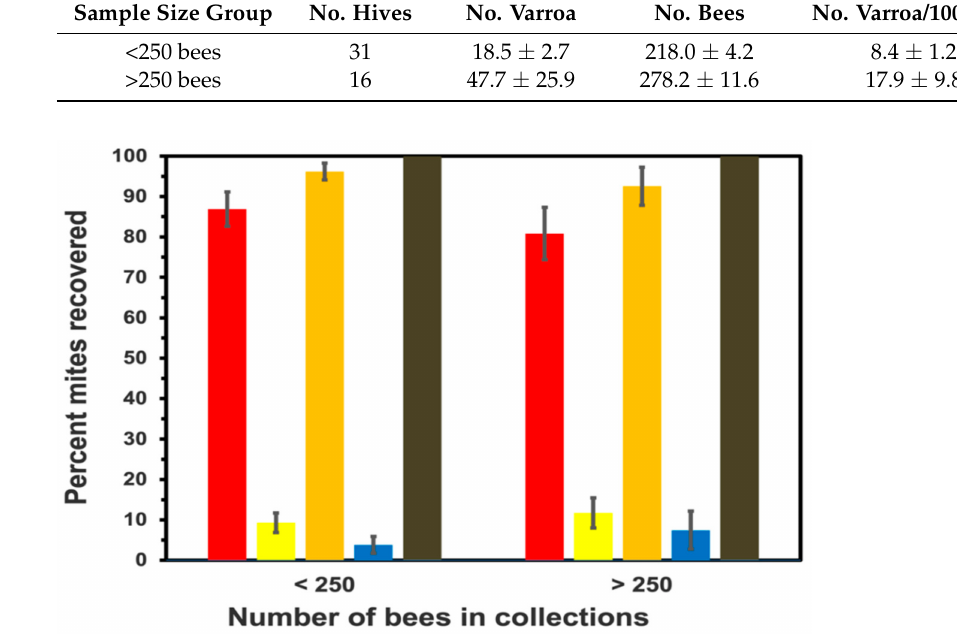
Figure 2. The percentage (mean ± standard err (se)) of Varroa dislodged from fewer or more than 250 collected honey bees after shaking the Varroa Shaking Device (VSD) for one minute with water (<250 N = 31; >251 N = 16 trials). The efficiency was estimated for first (red bar) and second (yellow bar) shaking periods, followed by the residual percentage collected from careful inspection of bees after the second shaking period (blue bars). The sum of percent recovery between the first and second shaking period and the second shake period and final visual inspection of bees for residual mites, are given by orange and black bars, respectively.